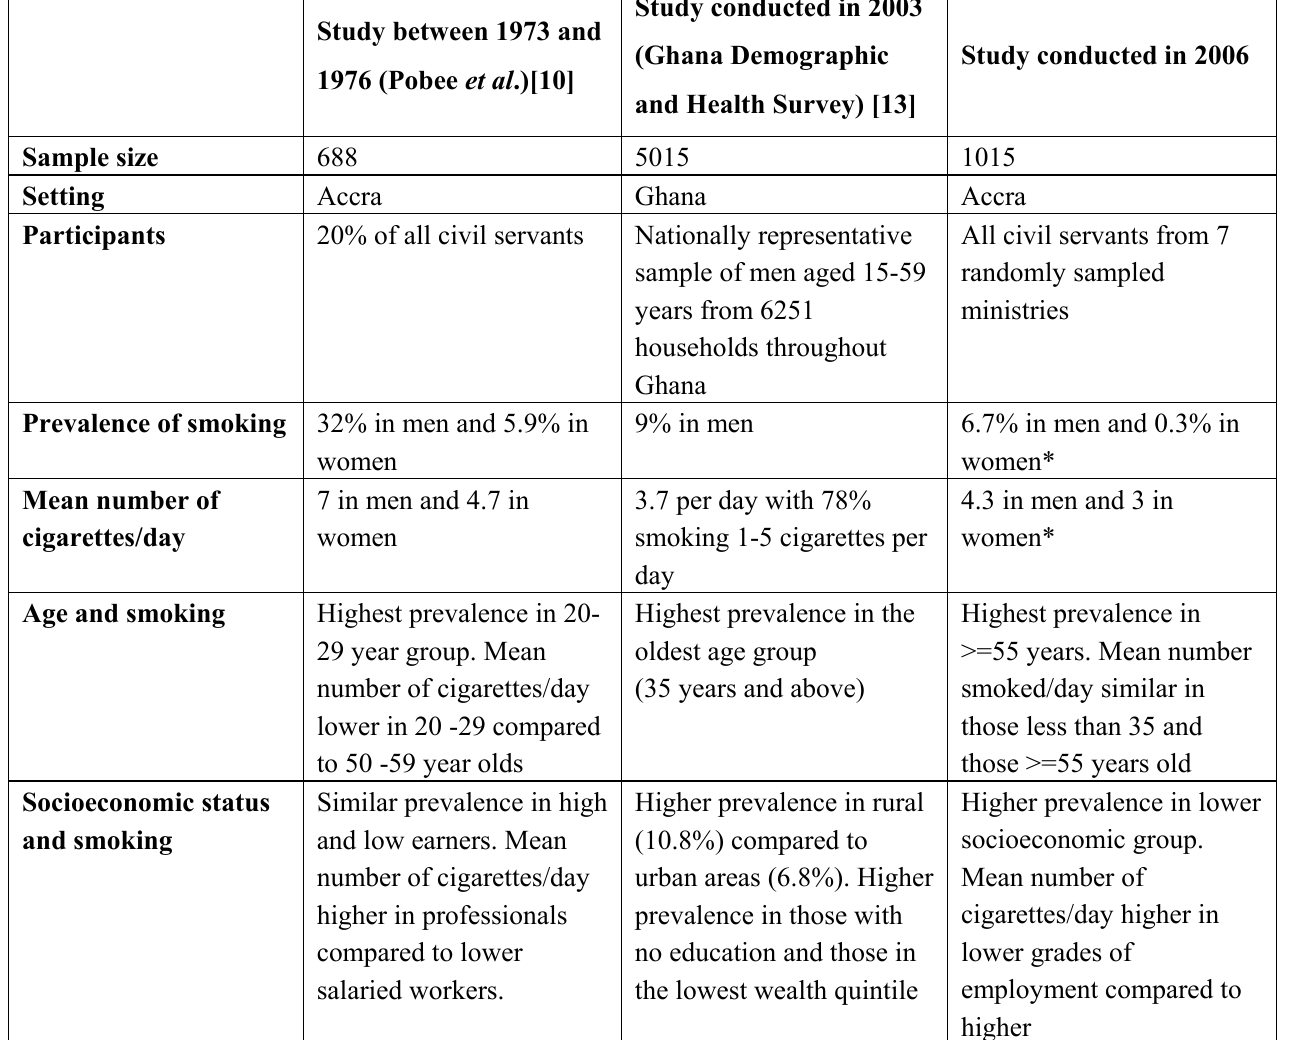
Table 2. Study and smoking characteristics compared between two studies of civil servants in Accra and the Ghana Demographic and Health Survey